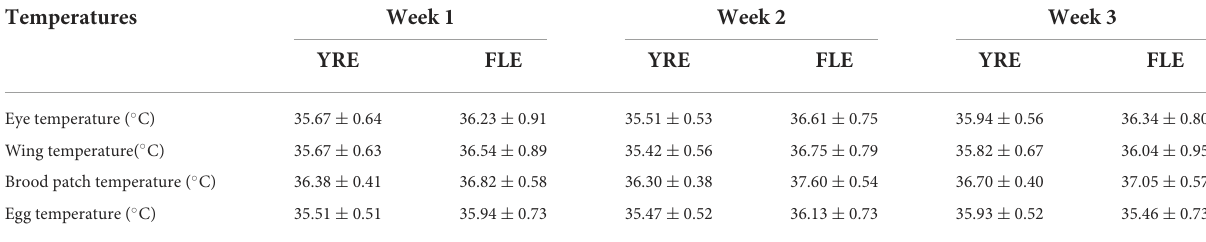
TABLE 2 Surface body temperatures of the two ecotypes (Yoruba, YRE, and Fulani, FLE) of broody hens and the average temperature of their eggs for the three weeks of the brooding period. Temperatures